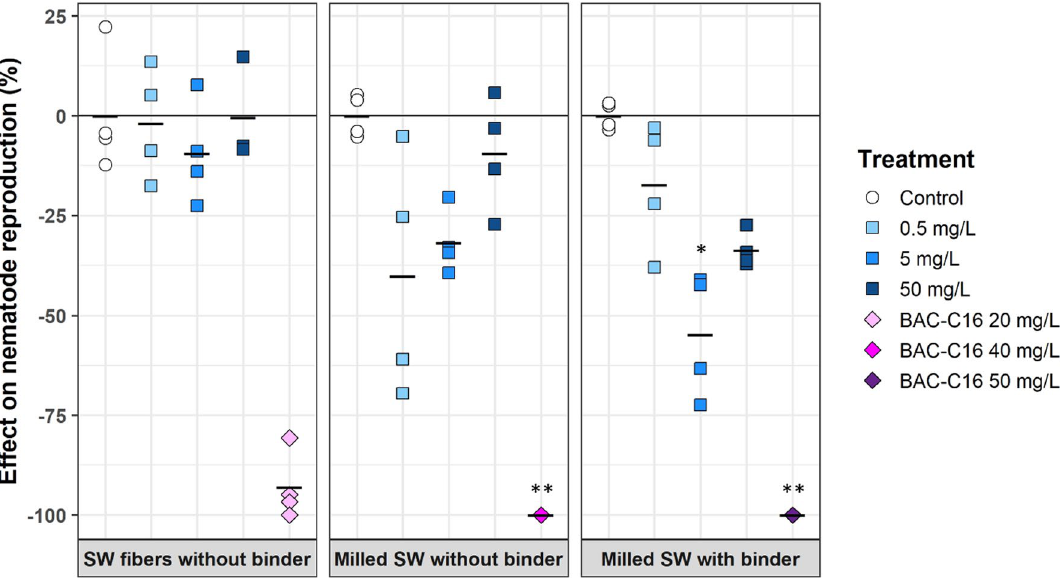
Fig. 8 Chronic effects (96 h) on the reproduction of C. elegans for the negative control (white), the eluates of three concentrations (0.5, 5 and 50 mg/L) of each of the three test materials (blue colors) and the positive control (BAC‑C16; violet colors) as individual values and means of n (black dash). Effects were calculated in comparison to the mean reproduction in the negative control and positive effect values show nematode reproduction stimulation, while negative values show reproduction inhibition. Asterisks denote significant differences between the treatments and the negative control (Dunn´s test: *: p < 0.05, **: p <